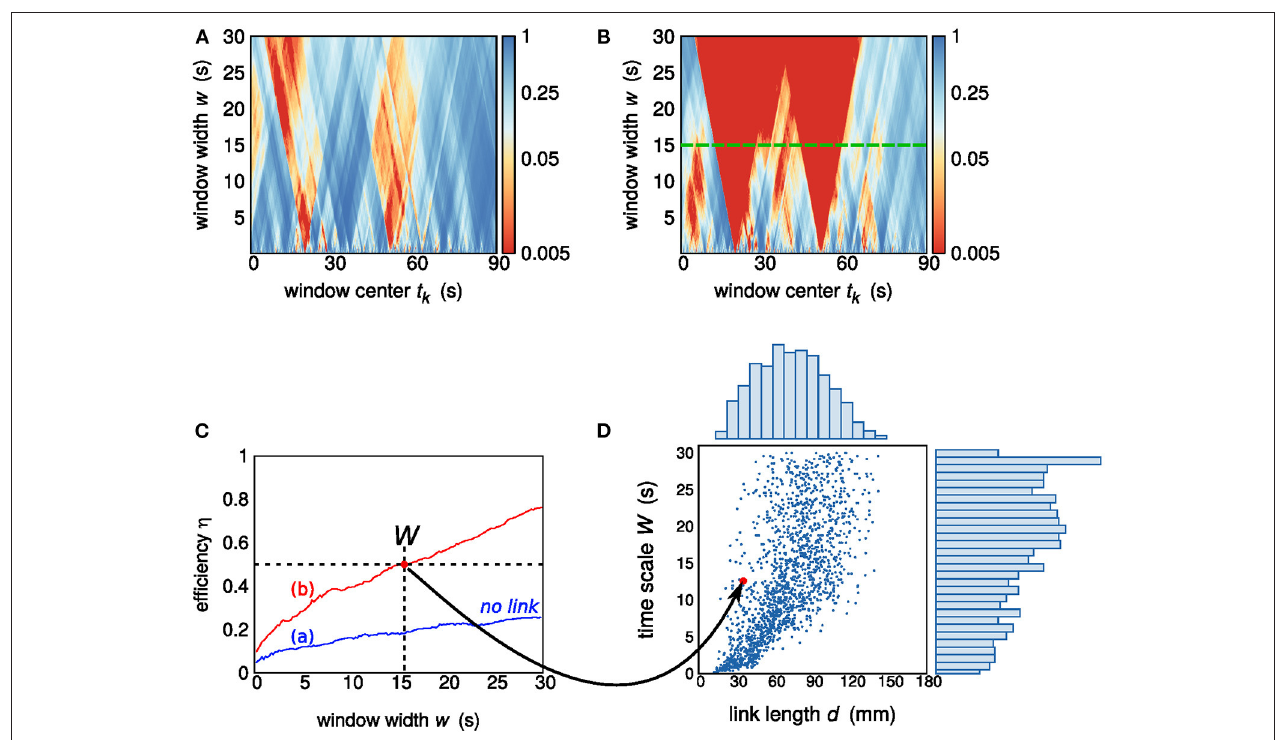
FIGURE 2 | (A,B) P -value diagrams p ( k , w ) of sections of sequences belonging to two pairs of nodes. The diagram in (A) corresponds to a pair that is not deemed to be linked, while a link exists in (B) . The green dashed line shows the link time scale W = 15s. (C) Efficiency η as a function of the window width w : the blue and red lines corresponds to the diagrams in (A,B) , respectively. The efficiency threshold of 0.5 is reached by the red efficiency curve at w = 15s. (D) Scatter plot, for one subject, of the assessed links: each point (link) is identified by the corresponding Euclidean distance d and time scale of observability W . The pair of nodes exhibiting a link contributes to the scatter plot with a point of abscissa given by the distance d between the two nodes (32mm) and ordinate given by the resulting time scale W (15s). Two histograms, showing the sample marginal probability distributions of d and W , are also